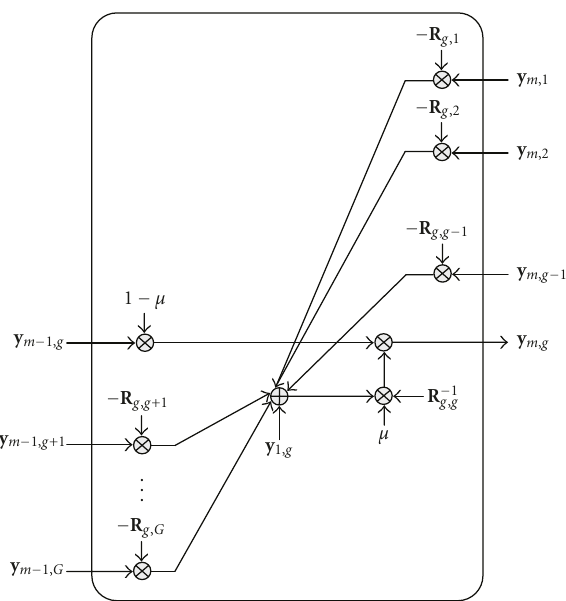
Figure 3: Basic interference cancellation unit for the symbol-level BSOR-GSIC